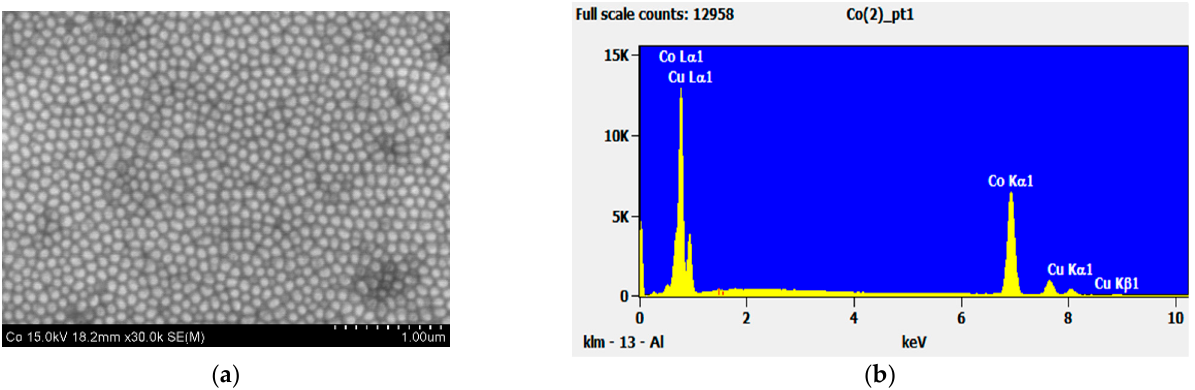
Figure 2. ( a ) SEM photo of Co nanocones and ( b ) mapping analysis spectra.